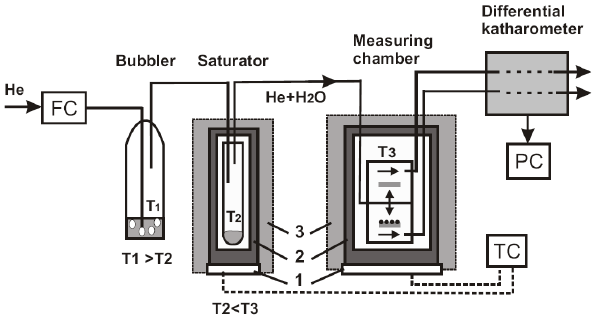
Fig. 1. Schematic set-up of the filter-based differential hygroscopic- ity analyzer (FDHA): FC – flow controller, TC – temperature con- troller, PC – computer. T1, T2, and T3 – temperature sensors. 1 – Peltier elements, 2 – copper housing (double wall cylinder), 3 – in-